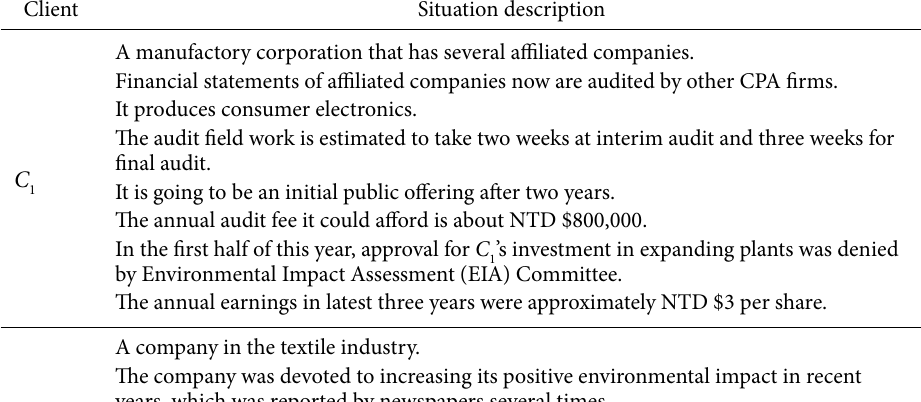
Table 3. Five potential clients’ circumstances. Client Situation